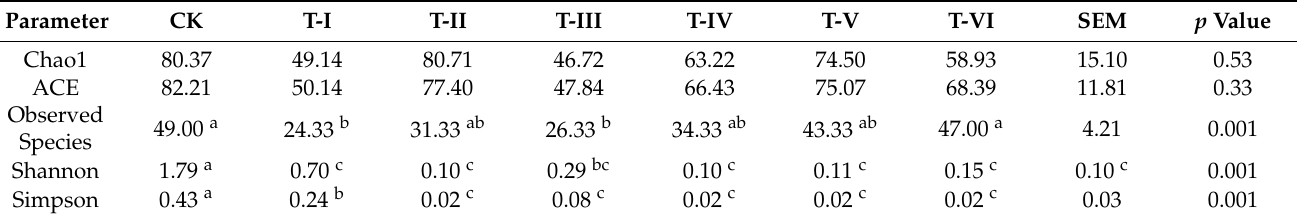
Table 2. Alpha diversity indices of microbial communities.